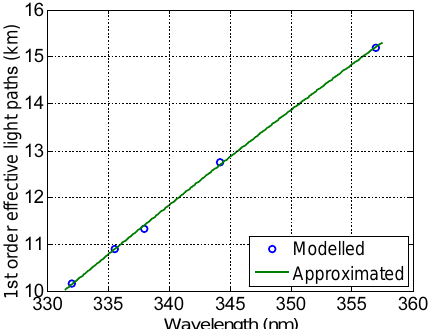
Figure 5. Effective light paths for limb geometry (TH = 18km, 1km layer from 18 to 19km) modelled by RTM at five distinct wavelengths and approximated afterwards by a fit with a Rayleigh cross section, its square plus an